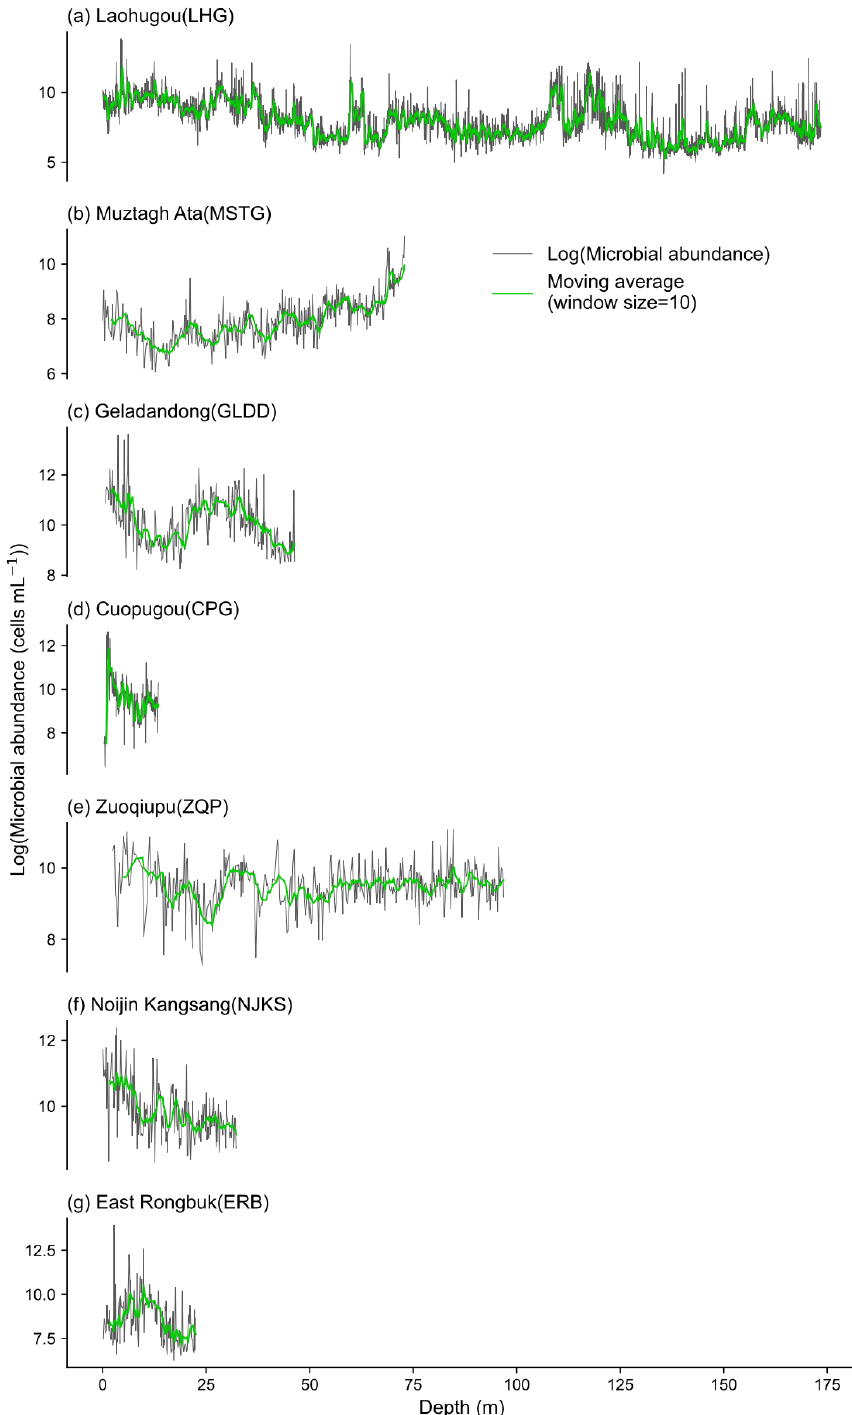
Figure 5. The variation of microbial abundance along depth in seven ice cores. The window size used in the moving average method was 10. Microbial abundance is